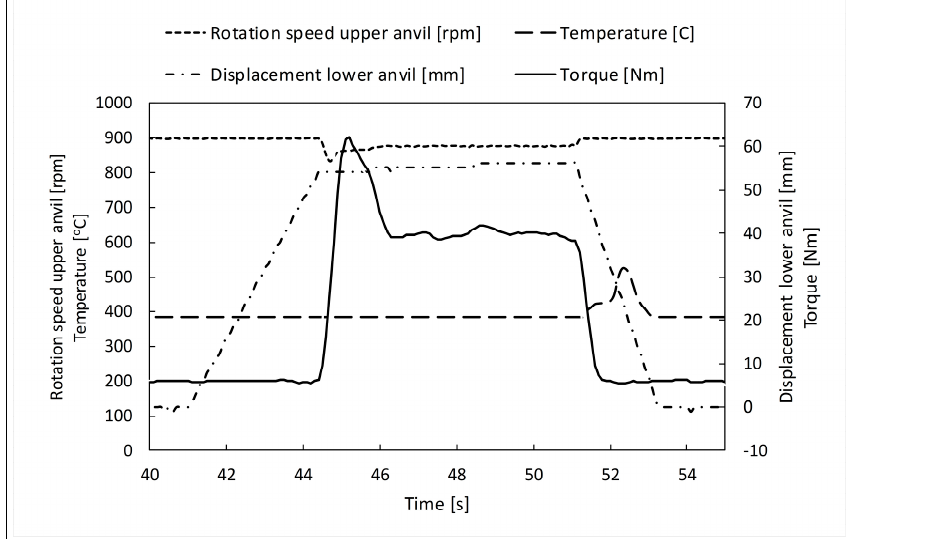
Figure 5. HSHPT experimental